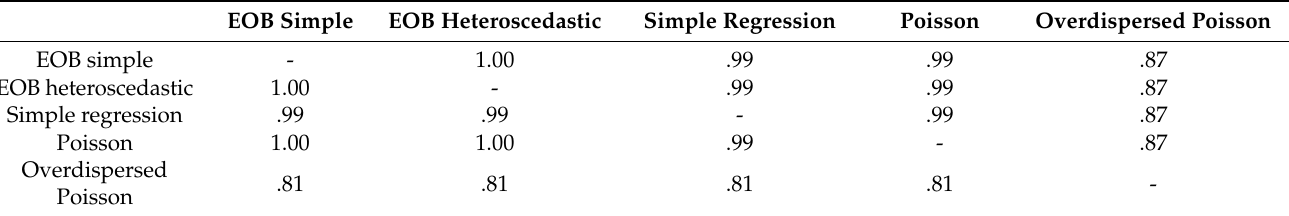
Table notes. Lower triangle: Correlations between various u estimates for citations as the dependent variable. Upper triangle: Correlations between various u estimates for cited papers as the dependent